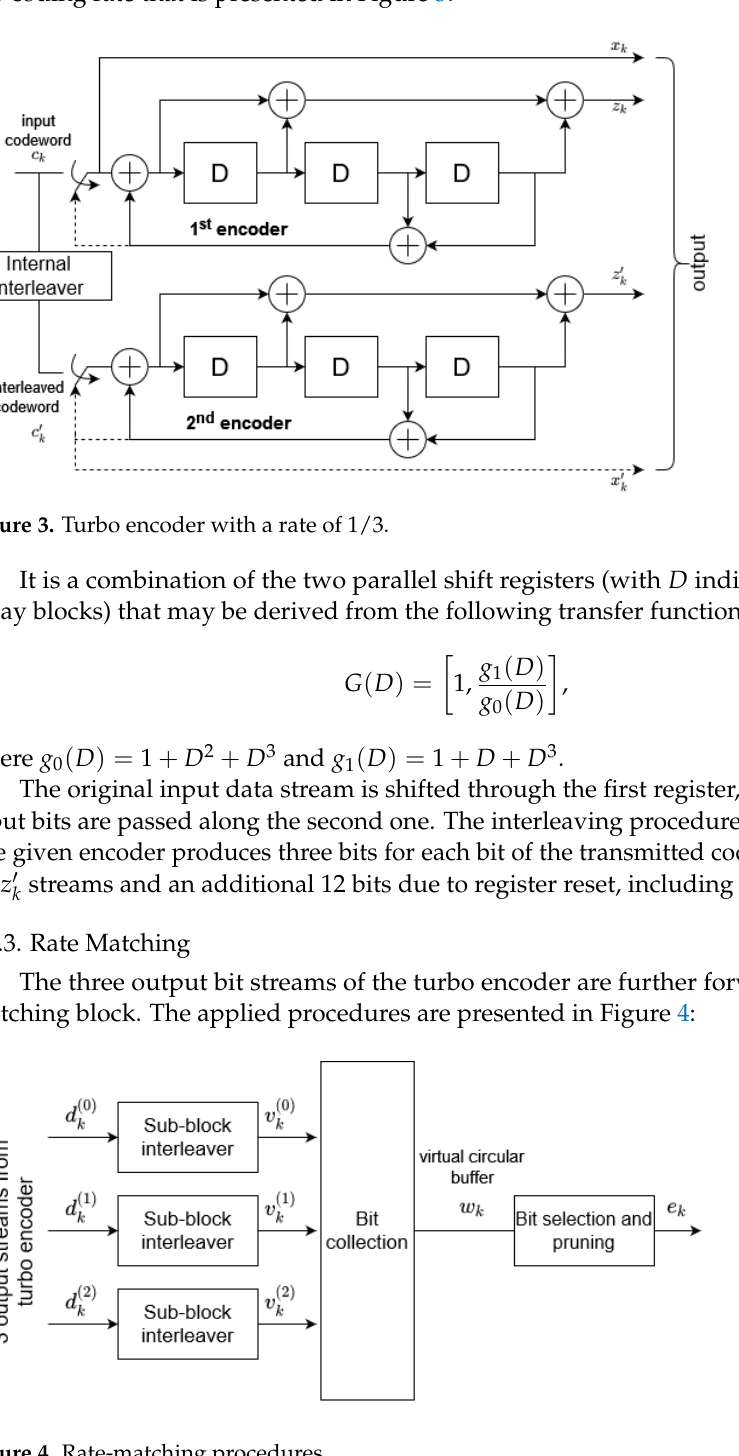
Figure 4. Rate-matching